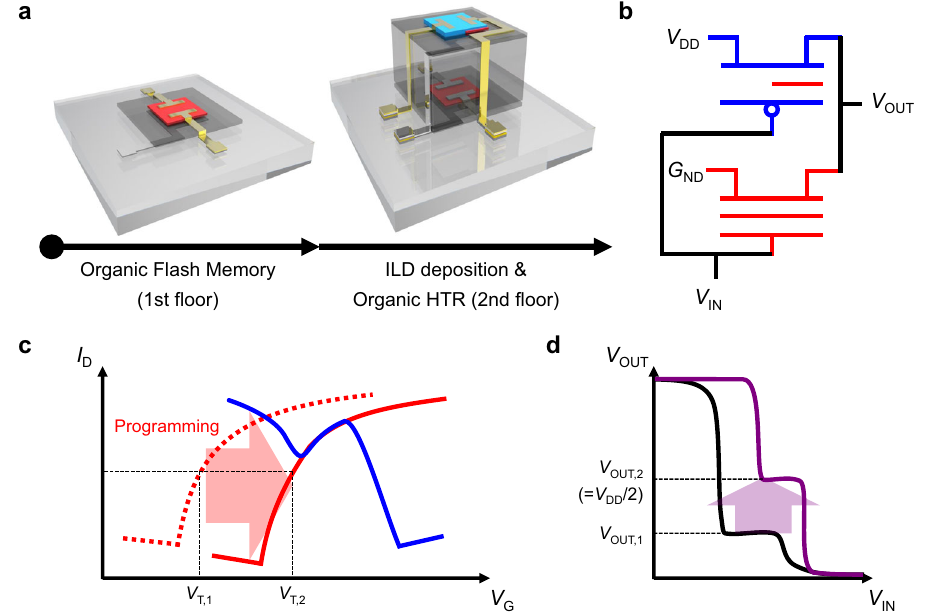
Fig. 1 Design of 3D T-inverter including the fl ash memory. a A schematic of device fabrication and b the vertically stacked 3-dimensional (3D) ternary logic inverter (T-inverter) consisting of the fl ash memory and heterojunction transistor (HTR). The schematic illustrations of c the transfer curve shift along with the memory programming, and d corresponding voltage transfer characteristic (VTC) of the 3D T-inverter.